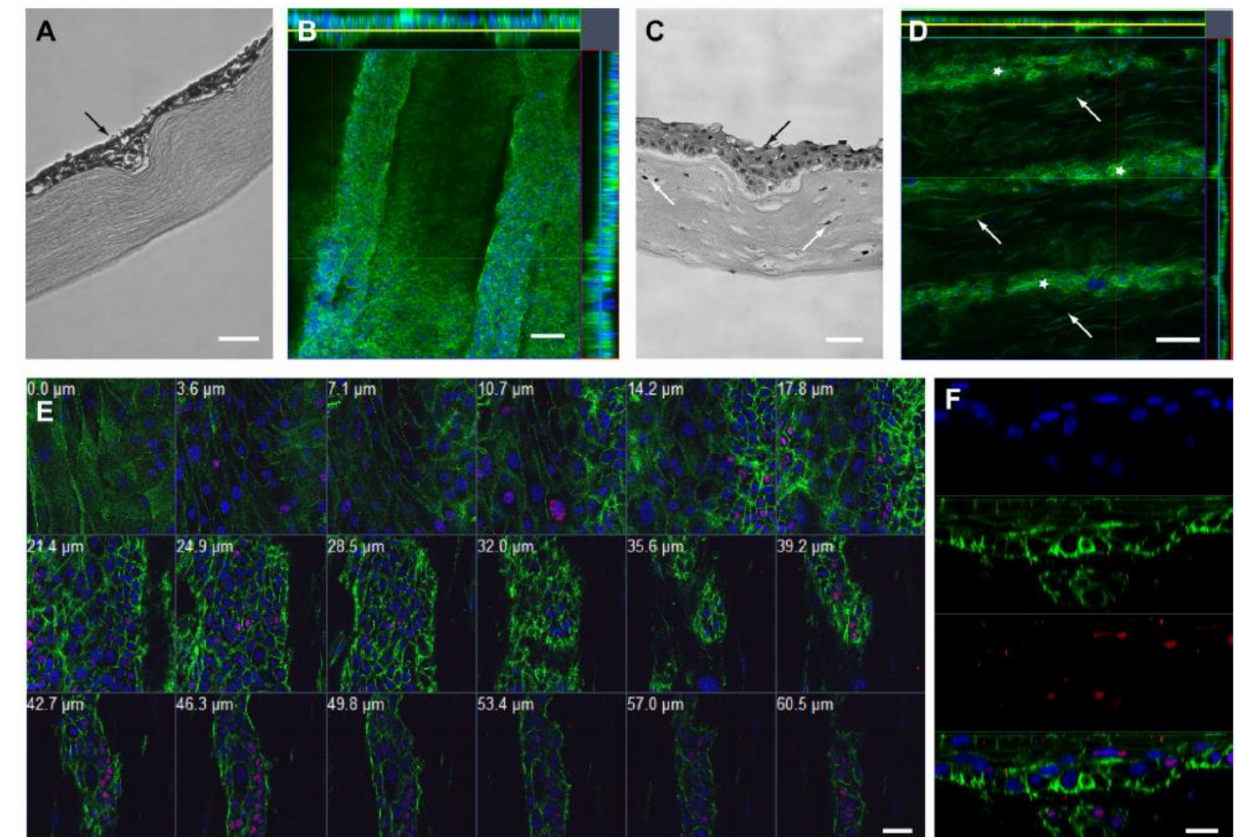
Figure 8. Cell-filled BLCs. ( A ) Shows an H and E-stained paraffin-embedded section of HCE-T cell-filled BLCs (black arrow) on RAFT construct. ( B ) Represents an orthogonal confocal image of HCE-T cells in BLCs stained with phalloidin (green) and DAPI (blue). Yellow line indicates Z-stack position on X -axis and blue line on Y -axis. ( C ) Shows an H and E-stained paraffin-embedded section of HLE cell-filled BLCs (black arrow) on the surface of HLF (white arrow) containing RAFT constructs. ( D ) Is a representation of an orthogonal confocal image of HLE cells in crypts (white stars) and HLF cells (white arrows) within the RAFT construct, both stained with phalloidin (green) and DAPI (blue). Yellow line indicates Z-stack position on X -axis and blue line on Y -axis. ( E ) Shows gallery view of a series of confocal Z-stack images showing HLE cell-filled BLCs and HLF cells within the RAFT construct stained with p63a (red), phalloidin (green) and DAPI (blue), with the depth from the epithelial surface indicated in mm. ( F ) Shows the confocal line scan image of the HLE cell-filled BLCs stained with p63a (red), phalloidin (green) and DAPI (blue). Scale bars: A, C: 50 µ m, B, G–I: 100 µ m, D: 200 µ m, E: 40 µ m, F: 20 µ m